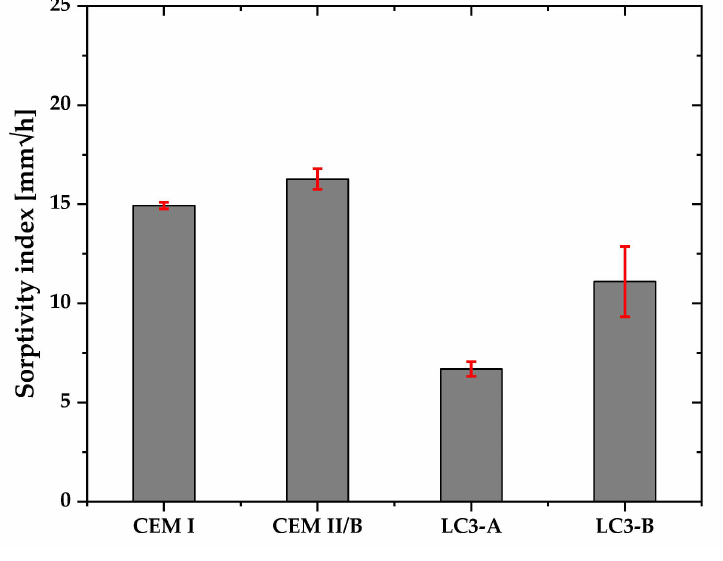
Figure 8. Water sorptivity of each mixture.